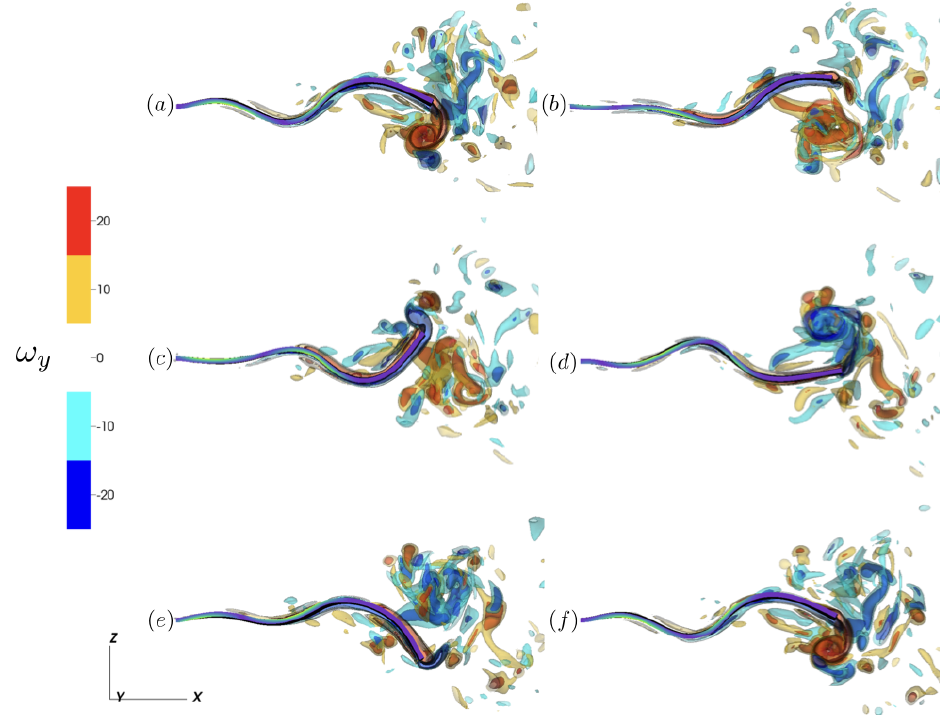
Figure 6. Isocontours of the y -component of vorticity ( ω y ) for A = 4 ( d ) 9.6 s, ( e ) 9.8 s, and ( f ) 10.0 s. For clarity, only the half plane is plotted. Tail color indicates the instantaneous strength of contraction ( γ